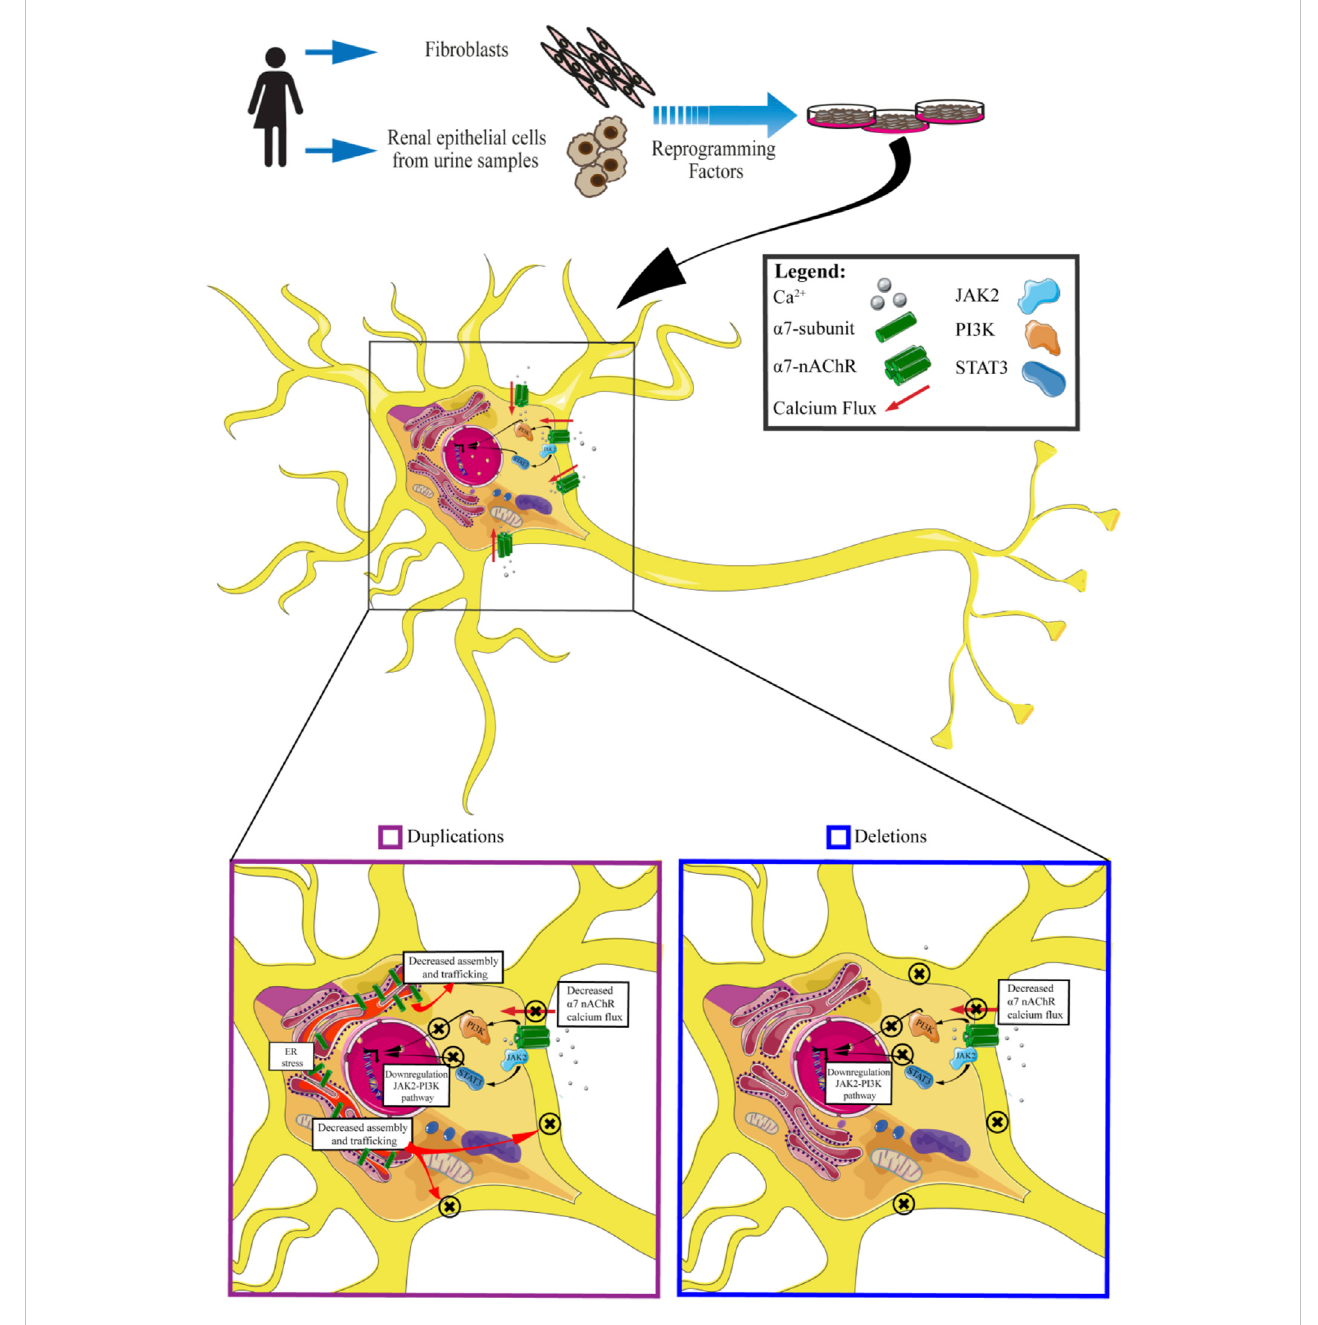
FIGURE 4 An insight into molecular effects of CNV 15q13.3. Cells carrying CNV duplications show decreased calcium fl ux associated with the α 7 receptor, downregulation of JAK2-PI3K pathway, decreased assembly and traf fi cking of nAchRs, and ER stress. Cells carrying CNV deletions exhibit decreased α 7nAchRs calcium fl ux and downregulation of JAK2-PI3K